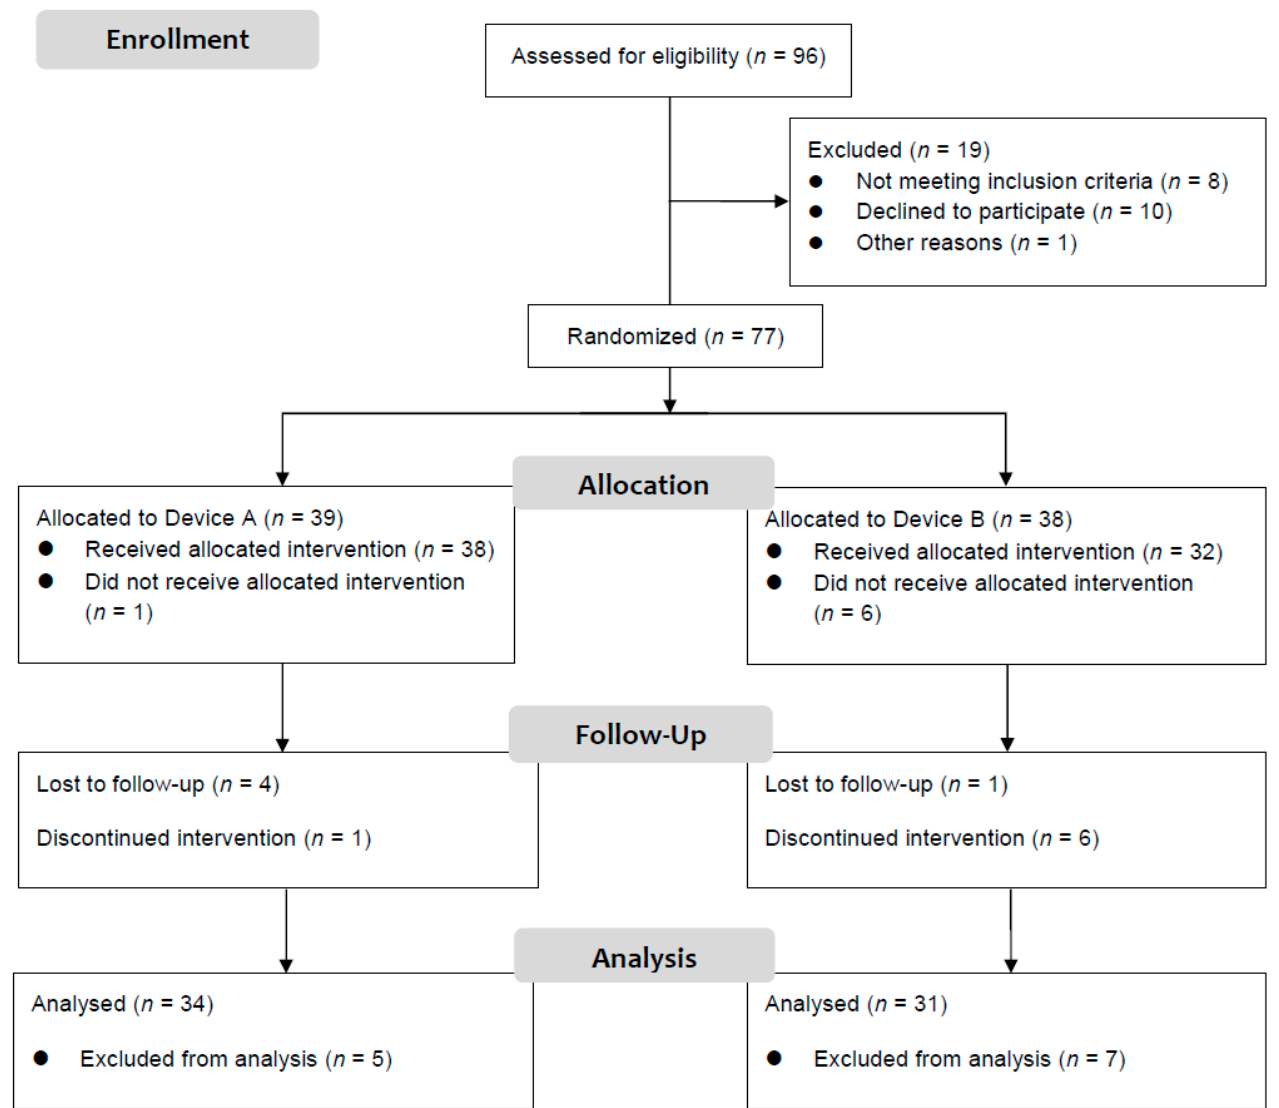
Figure 1. Study completion